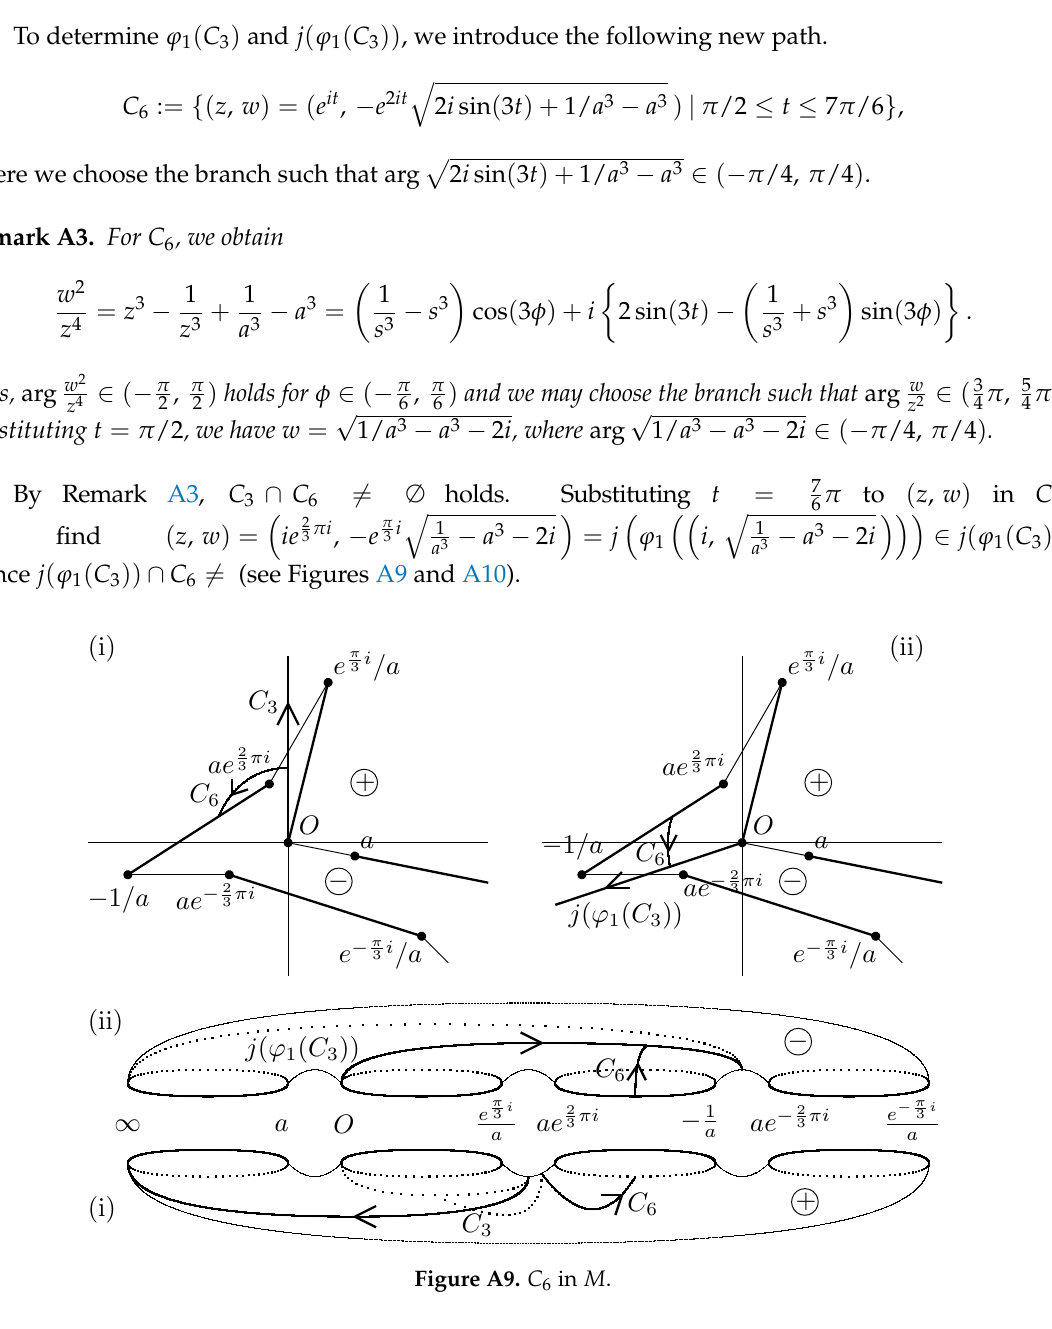
Figure A9. C 6 in M